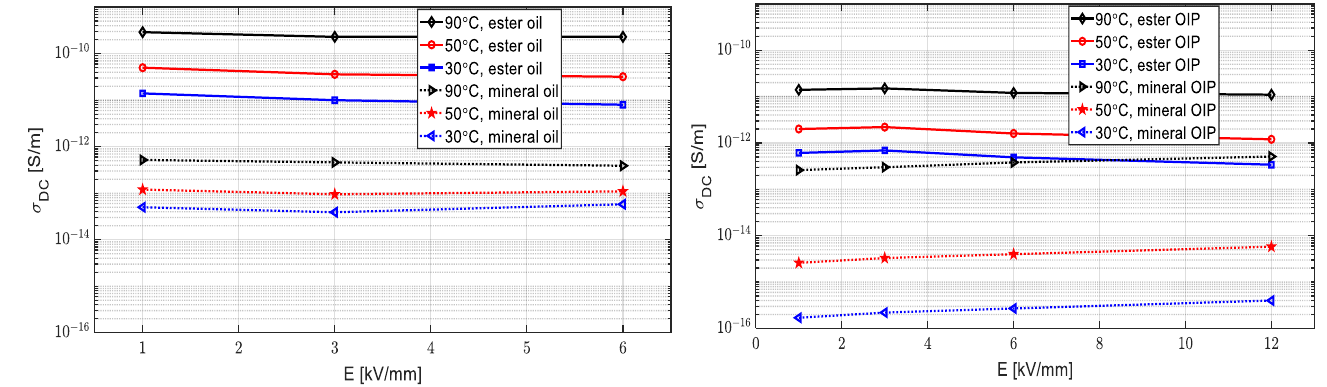
Figure 5. The measurement results on the ester and mineral oils/OIPs.